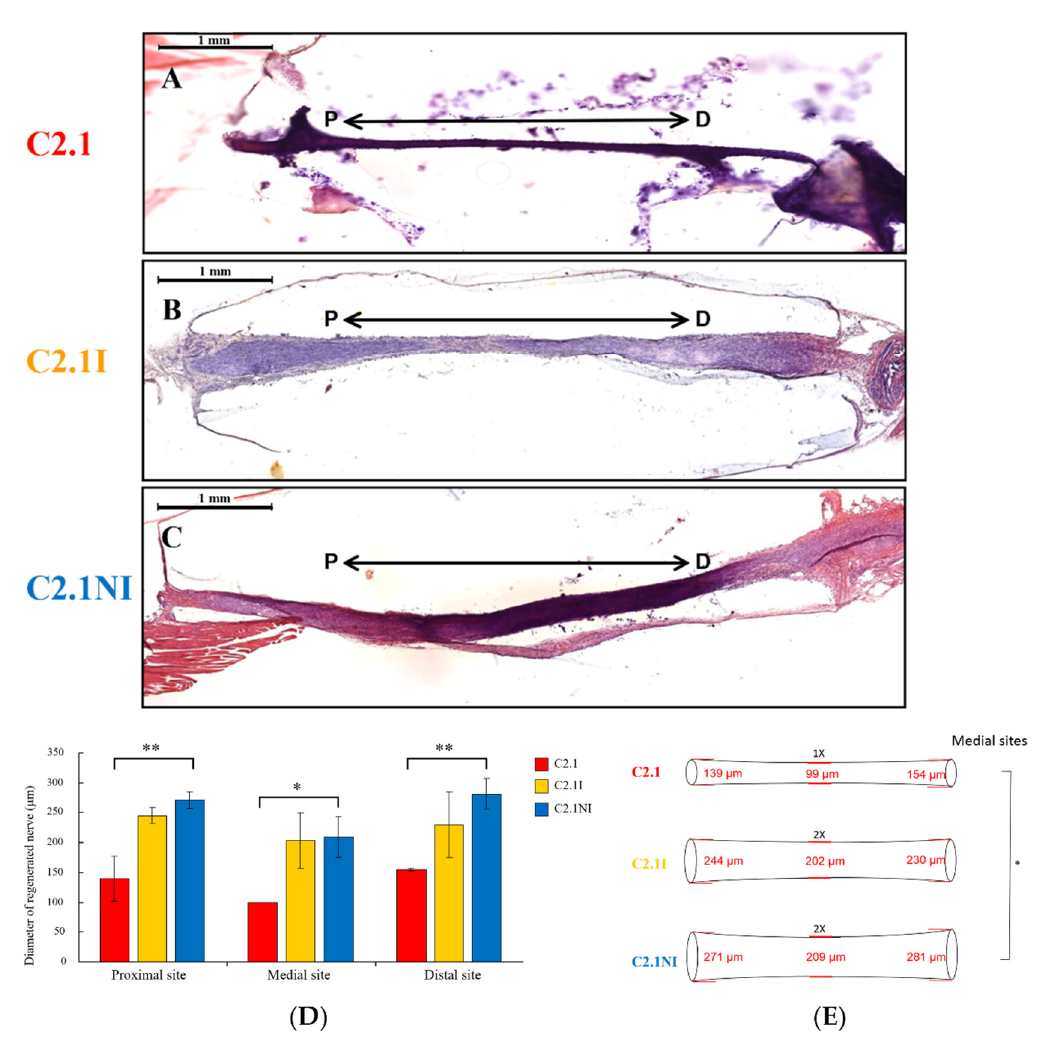
Figure 6. Implantation of PLGA conduits with human IL12p80 and NSCs promoted nerve regenera- tion in the sciatic nerve injury B6 mouse model. ( A – C ) H&E staining of the tissue sections for the meas- urements of the diameters in sciatic nerve regeneration. “P” is 1.0 mm from the proximal end of the conduit and “D” is 3.0 mm from “P”. ( D ) The quantitative results of regenerated nerve diameters at the proximal, medial, and distal sites. All data are presented as mean ± SEM (n = 2 in C2.1 and C2.1I groups, and n = 3 in C2.1NI group). ( E ) The illustration of the sciatic nerves in the different treatment groups. Scale bars in ( A – C ) are 1 mm. Statistical differences are indicated by * p < 0.05 and ** p < 0.01.